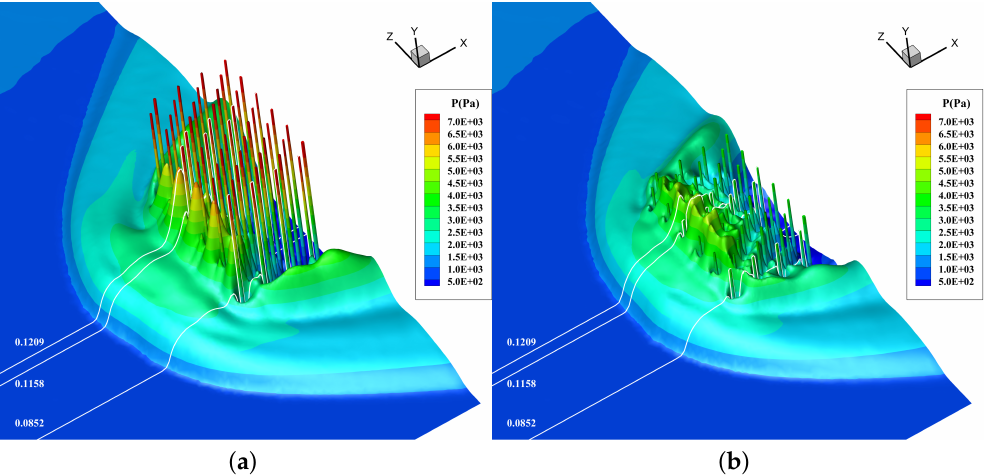
Figure 14. Visualization of Lower Surface Pressure Distribution of Case 4 and Case 5 ( y -Axis Assigned to Surface Pressure). ( a ) Case 4 ( C M = − 0.006832), ( b ) Case 5 ( C M =